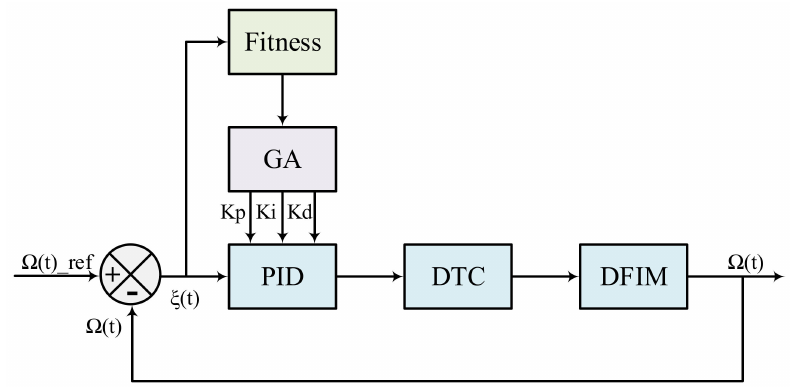
Figure 2. Simplified structure of the PID-DTC optimized by the GA. Selection, crossover, and mutation are essential steps of GAs, which belong to evolu- tionary algorithms that are based on techniques inspired by evolutionary biology. Genetic algorithms are a subset of evolutionary algorithms that apply techniques stimulated by